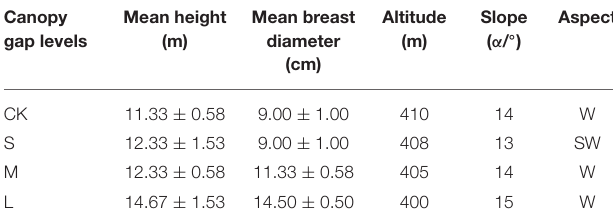
TABLE 1 | Basic conditions of the study